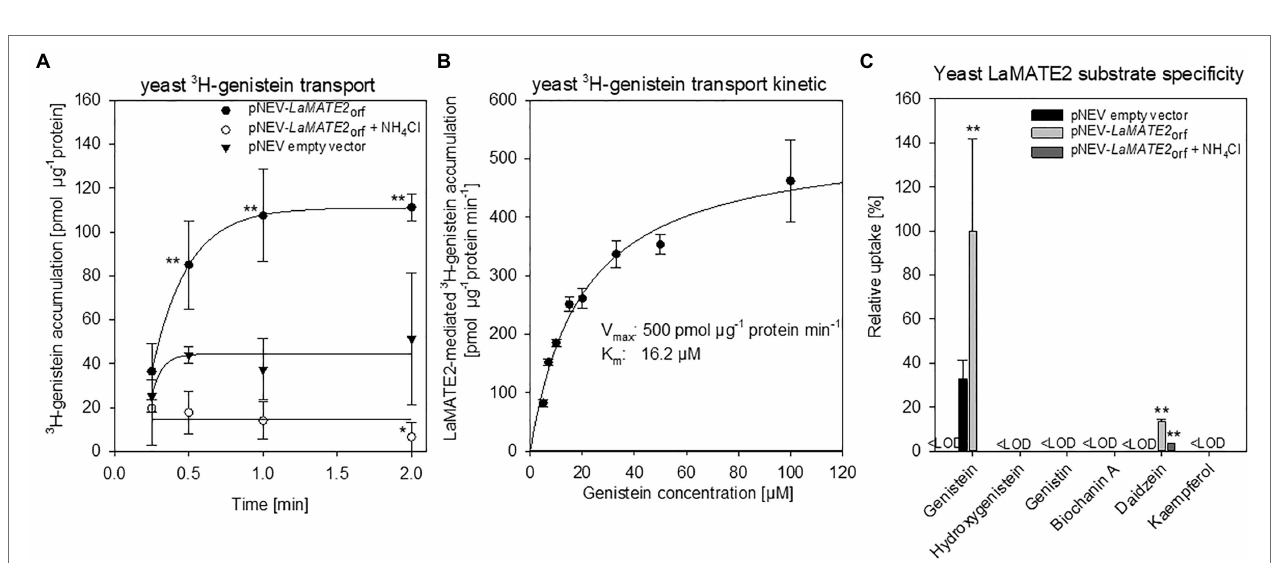
FIGURE 7 | Transport of phenylpropanoid compounds mediated by LaMATE2. LaMATE2-mediated transport rate of phenylpropanoids in yeast microsomal membrane vesicles. (A) Time-dependent accumulation of 3 H-genistein in yeast microsomal membrane vesicles. Membrane vesicles were isolated from yeast transformed with the empty vector (pNEV empty vector) or transformed with pNEV- LaMATE2 ORF . The yeast vesicles were incubated up to 120 s in presence of 5 μ M 3 H-genistein: To determine the effect of the pH gradient, 25 mM NH 4 Cl was added in an assay solution (pNEV- LaMATE2 ORF + NH 4 Cl), as uncoupler of the proton gradient. (B) Concentration-dependent transport of 3 H-genistein by LaMATE2 in yeast vesicles. Vesicles were incubated for 30 s in the assay solution containing 3 H-genistein at different concentrations (from 5 to 100 μ M). The kinetic parameters of 3 H-genistein uptake were calculated by subtracting uptake rates recorded in the empty-vector vesicles using the Hanes–Woolf plot. (C) Substrate specificity of LaMATE2 transporter was evaluated in presence of genistein, hydroxygenistein, genistin (glycosylated genistein), biochanin A (methylgenistein), daidzein or kaempferol (5 μ M, 30 s). All data are expressed relative to pNEV- LaMATE2 ORF -transformed yeast. Data are mean ± SD of three independent experiments (Asterisks refers to statistically significant differences among the mean value in comparison to empty vector sample within each time point; capital letters refer to statistically significant differences among the mean value, ANOVA Holm–Sidak, N = 6, ** p < 0.01, <LOD: below detectable